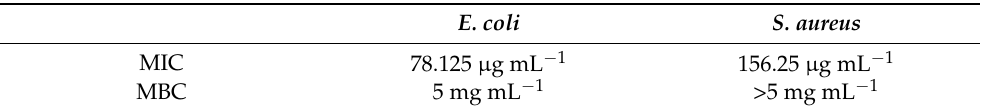
Table 3. Minimum inhibitory concentration (MIC) and Minimum bactericidal concentration (MBC)